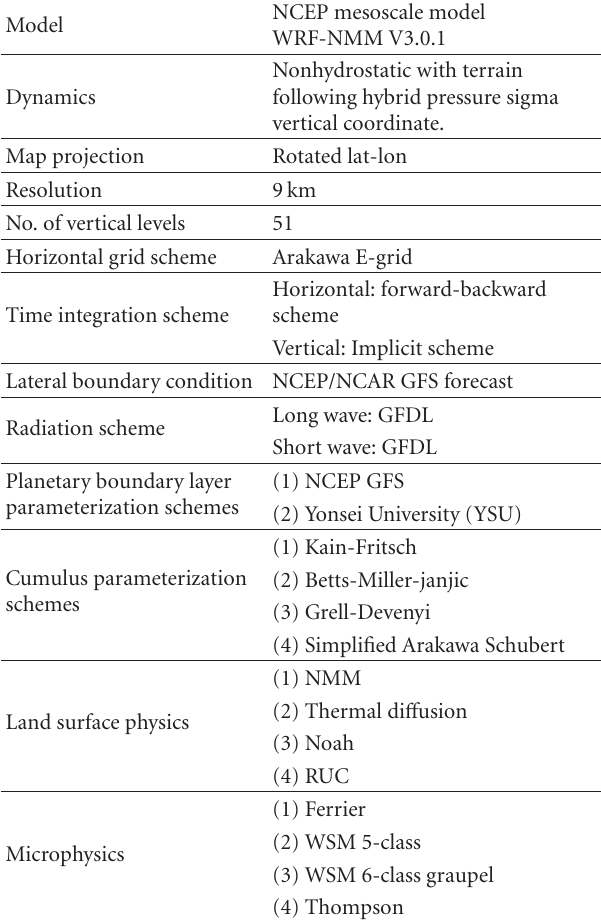
Table 1: Details of the WRF-NMM model